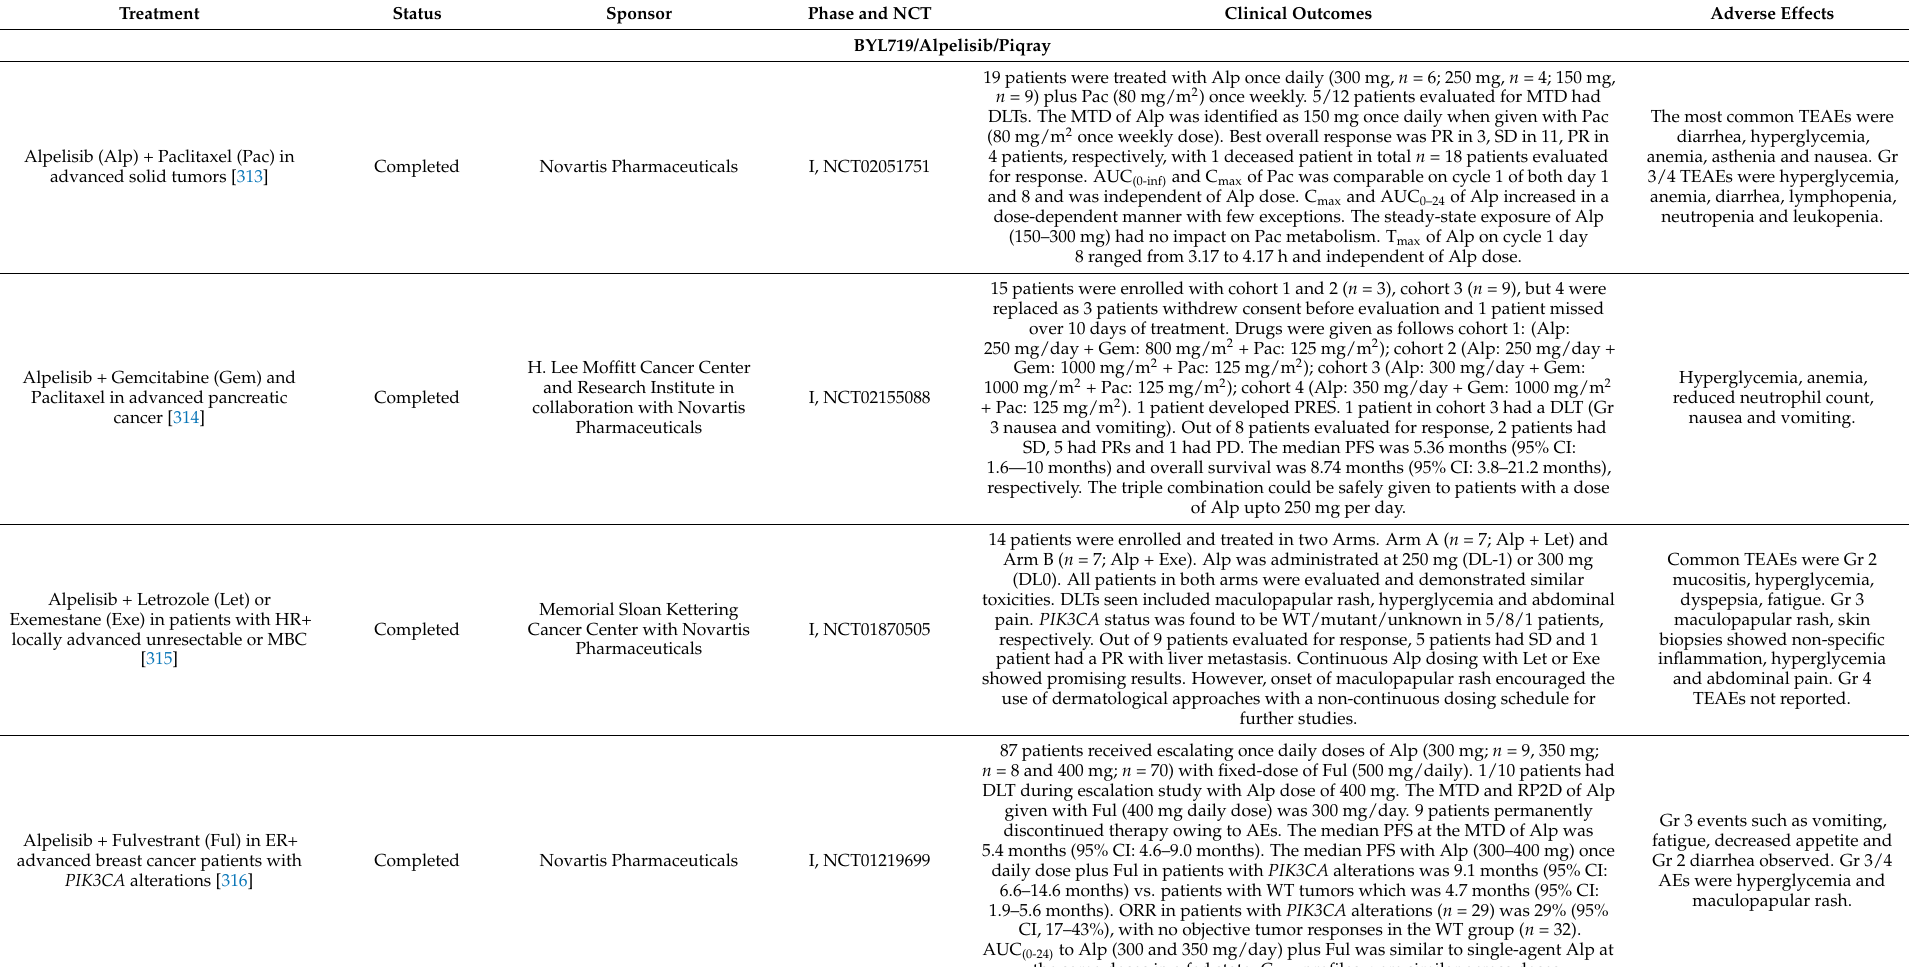
Table 2. Summary of trials, outcomes and adverse events associated with isoform-specific PI3K inhibitors in various phases of clinical